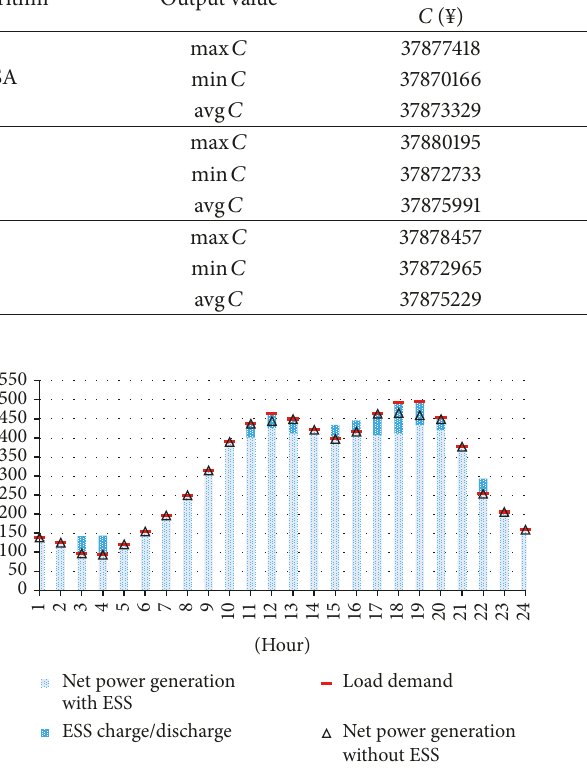
Table 5: Comparison of optimal installation and related costs predicted by the MHSA, HSA, and PSO in Case 2. Algorithm